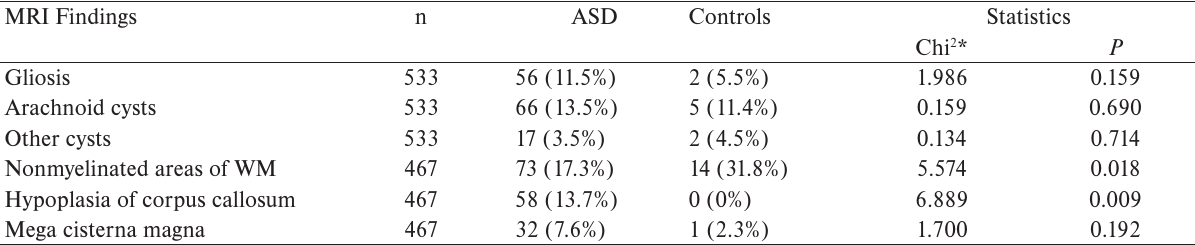
Table 2. Summary of frequent MRI findings in the ASD and the control